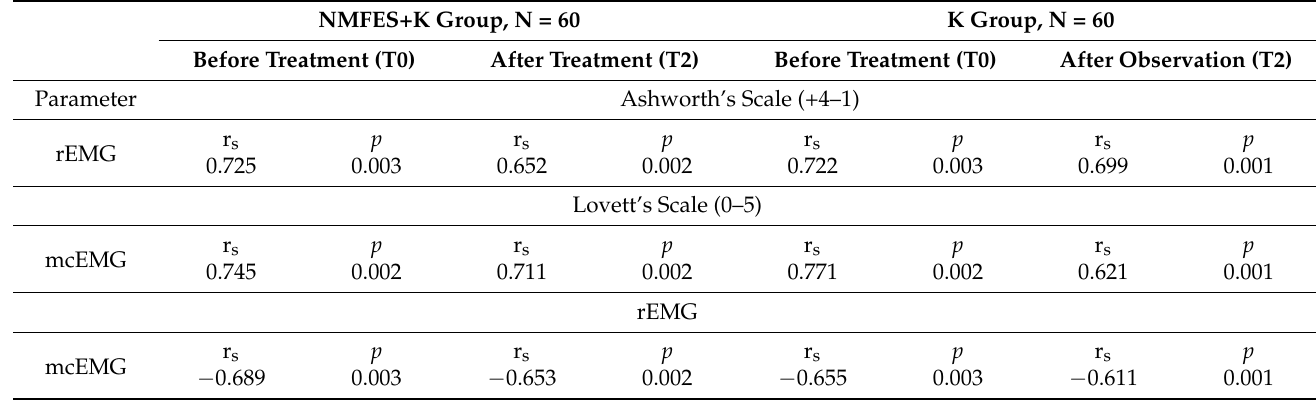
Table 4. Spearman’s rank correlation (r s ) of tests results obtained on the symptomatic side before and after treatment in the two groups of patients. Cumulative data from the wrist flexors and calf muscles are presented. p ≤ 0.05 was assumed as statistically significant for rank